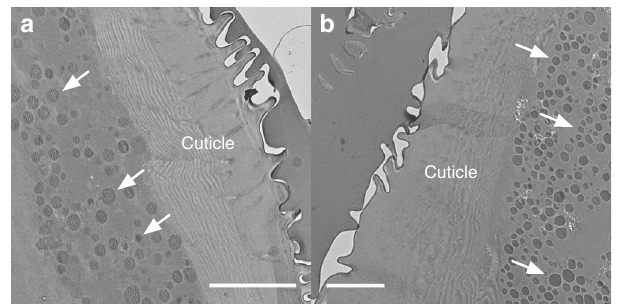
Fig. 7 TEM micrographs of the abdominal cuticle. Abdominal TEM micrographs of M. robinsoni ( a ) and M. chrysomelas ( b ). The randomly organized dark granules in the hypodermis under the cuticle are melanosomes (white arrows). Scale bar: 5 μ